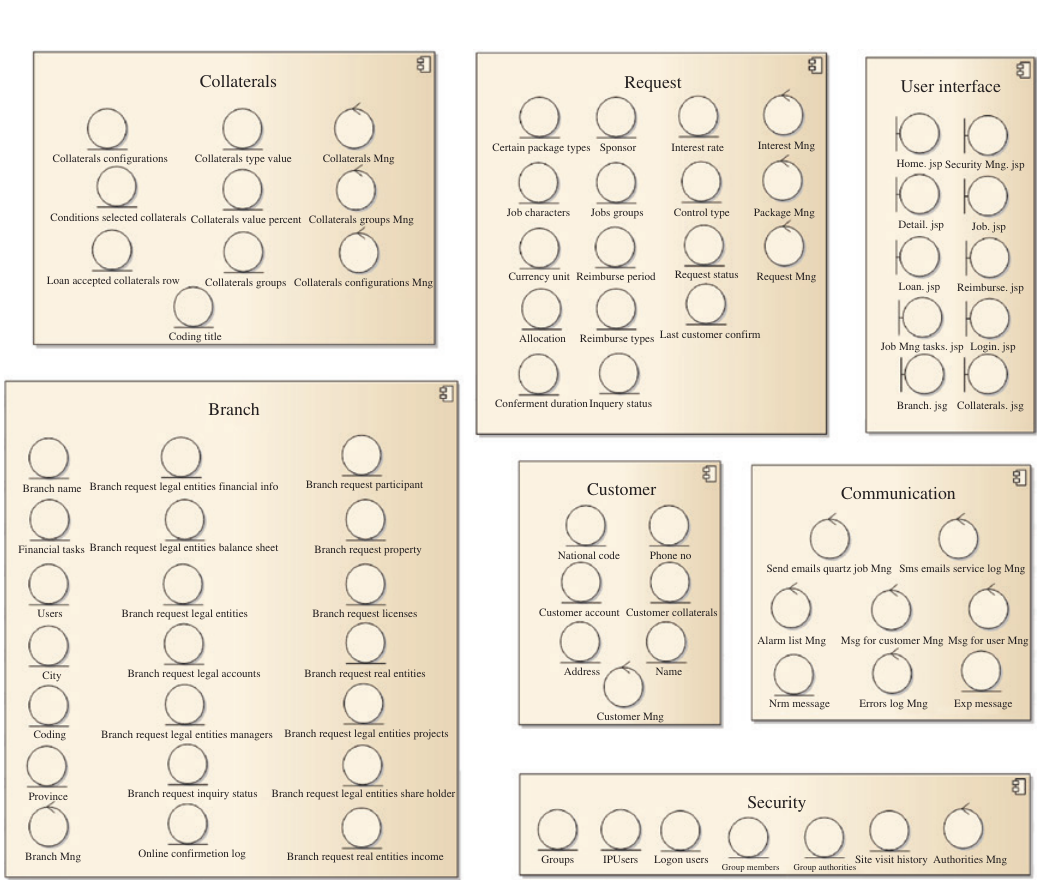
Figure 5: Components of the LGS Case Identified Automatically by